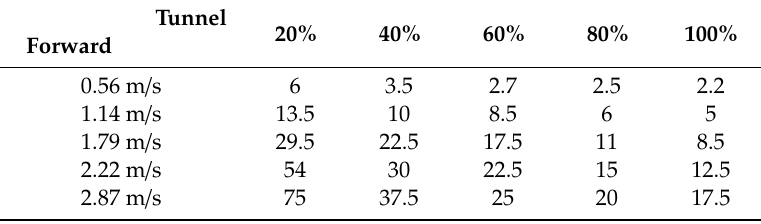
Table 6. Turning radius of ZFAUV at different speed.